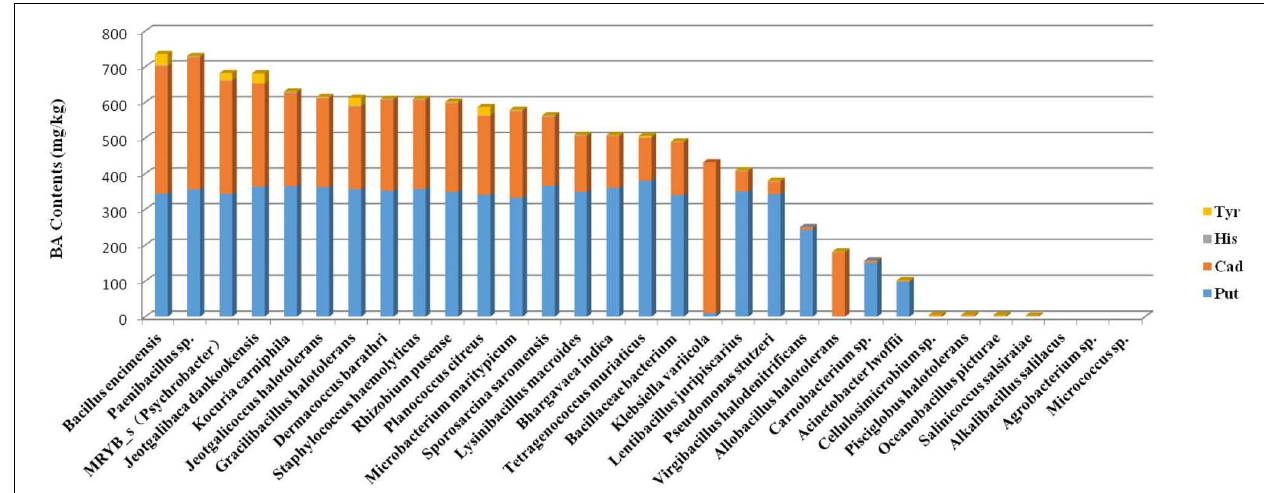
FIGURE 3 | Ranking of the total amount of BAs produced by different